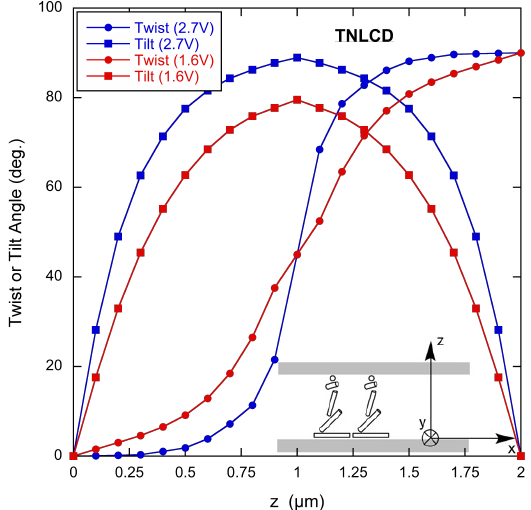
Figure 5. Twist and tilt director angles for the twisted nematic LCD at two different voltages using the genetic algorithm ( k 11 = 6.4 pN, k 22 = 4.0 pN, k 33 = 10 pN, d = 2 µ m). Inset: schematic of the cell. The twist angle is measured from the x -axis in the xy-plane. The tilt angle is measured perpendicularly from the